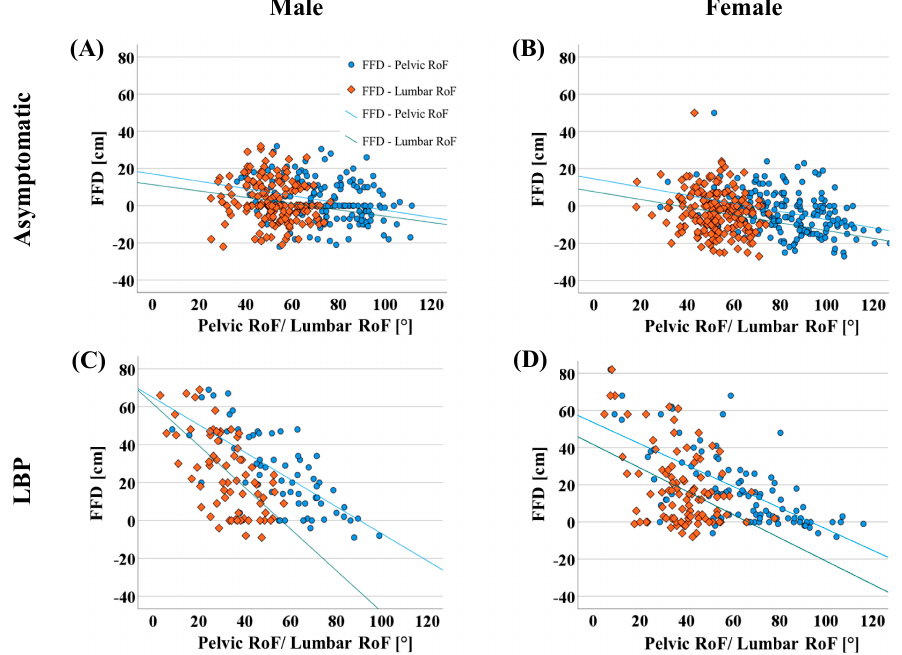
Figure 2. Correlation of lumbar-RoF and pelvic-RoF with finger-floor distance in asymptomatic males ( A ), asymptomatic females ( B ), symptomatic males ( C ), and symptomatic females ( D ).